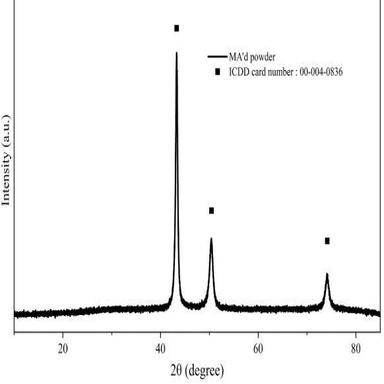
The XRD spectrum of the MA'd powder with the marked peaks of the prominent copper lattice.